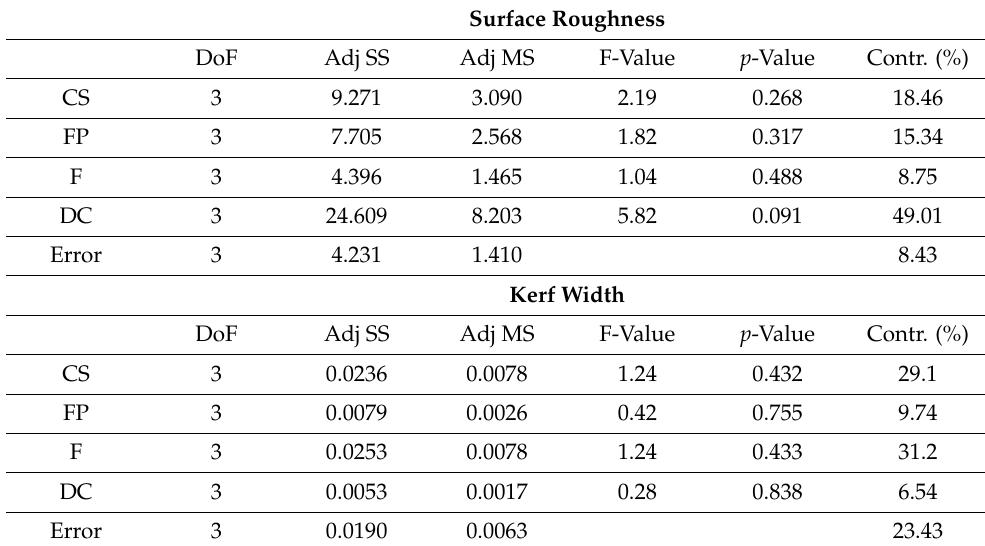
Table 4. Contribution ratios and ANOVA results on surface roughness and kerf width.